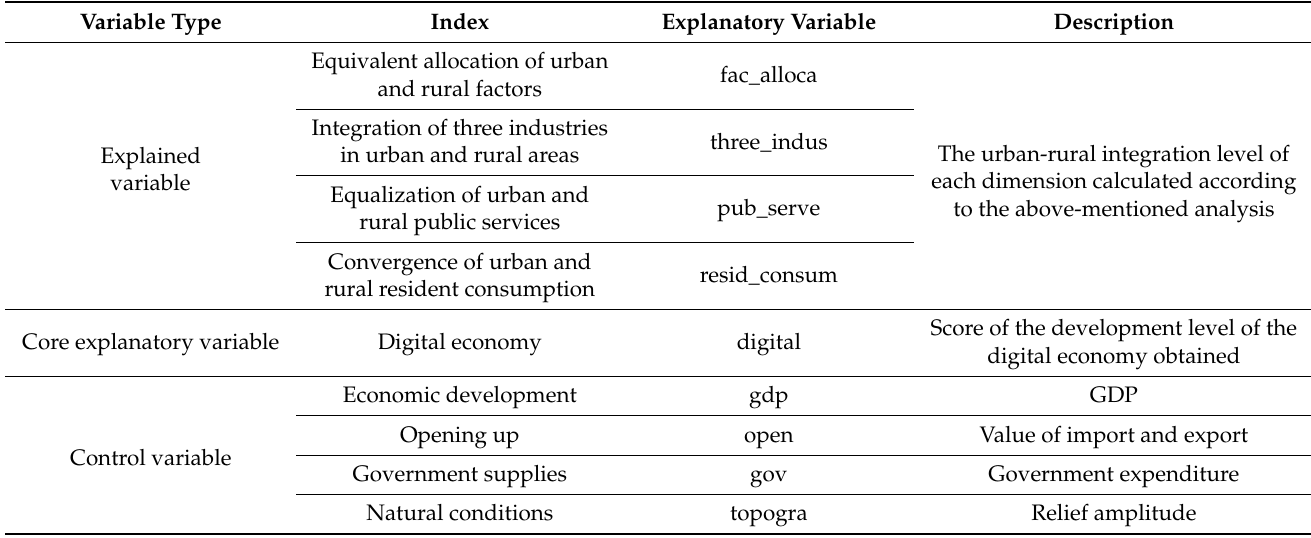
Table 4. Description of variables.